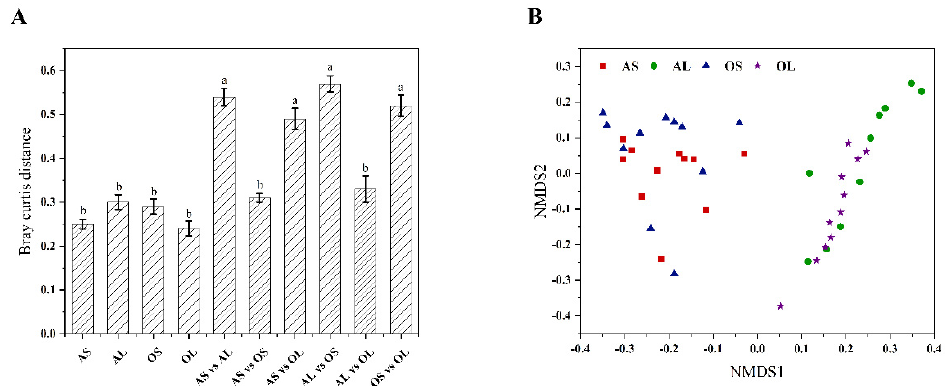
Figure 2. The beta diversity index and structure analysis of fecal microbiome in giant pandas. ( A ) The intra- and inter-group Bray–Curtis distance. ( B ) Non-metric multidimensional scaling (NMDS) ordination plot derived from the Bray–Curtis distances in feces of giant pandas. AS ( n = 11), adult giant pandas fed with bamboo shoots; AL ( n = 11), adult giant pandas fed with bamboo leaves; OS ( n = 11), old giant pandas fed with bamboo shoots; OL ( n = 11), old giant pandas fed with bamboo leaves. In panel A, values are presented as mean ± standard error; bars with different letters denote a significant difference ( p < 0.05).